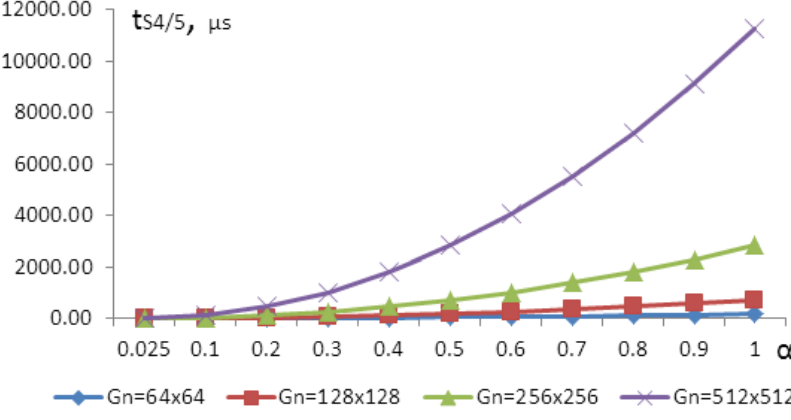
Figure 4. The time of the image